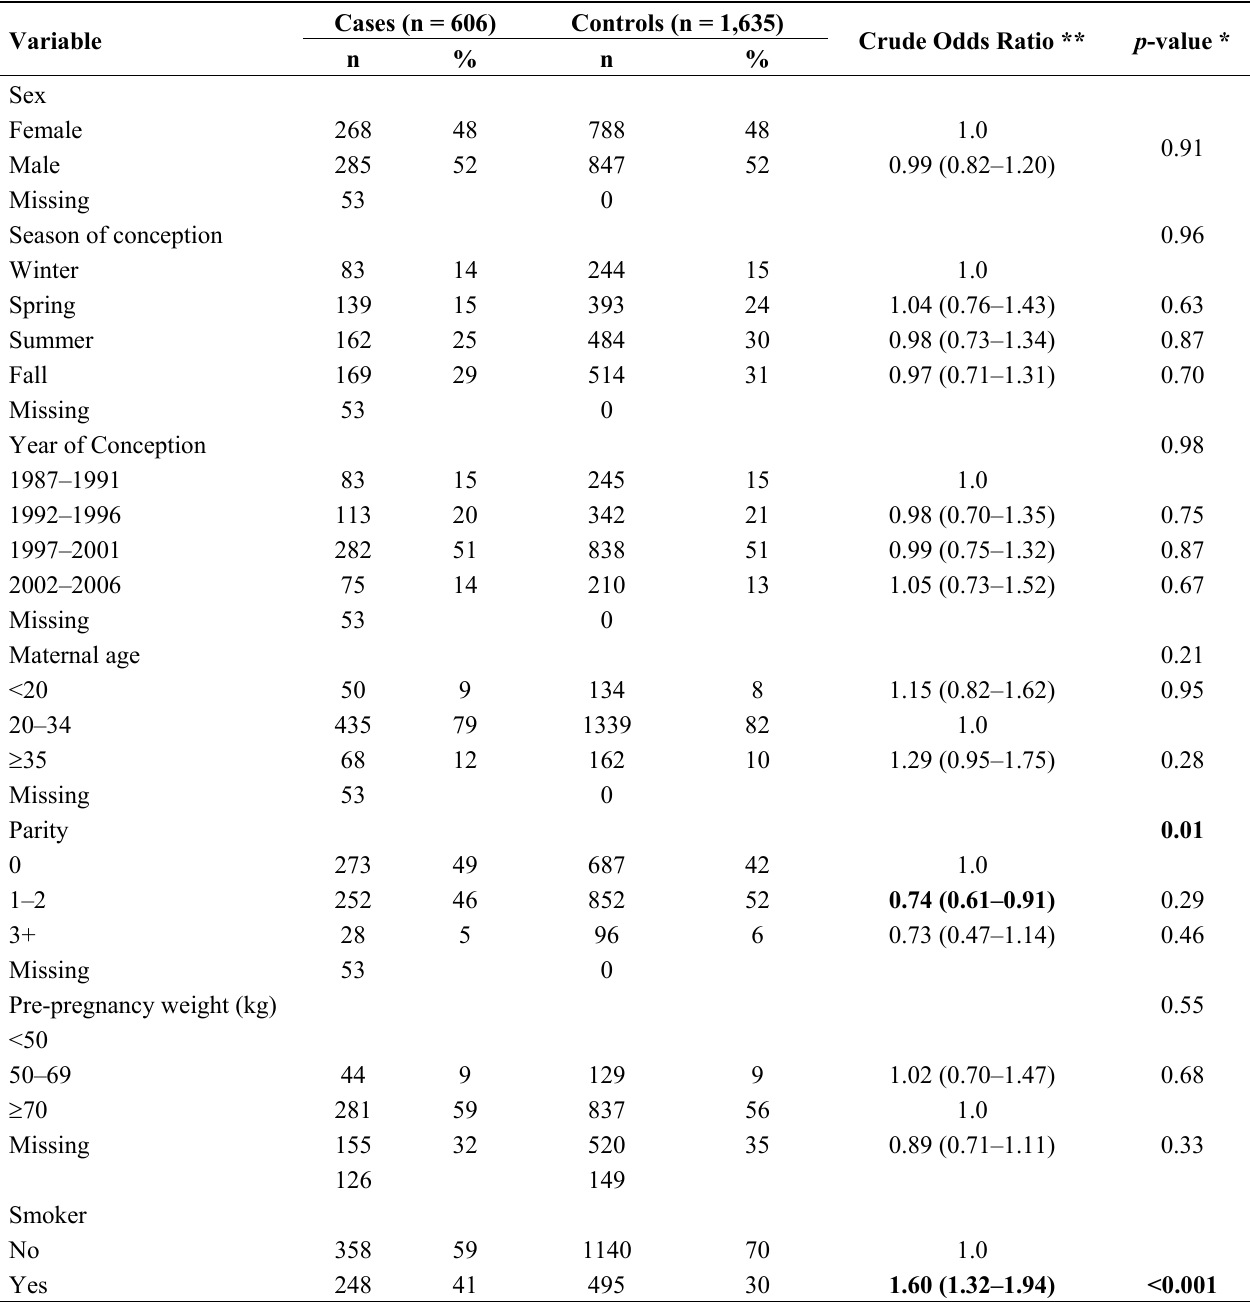
Table 3. Distribution of matching, demographic, health and water source variables, including nitrate exposure level, between cases of congenital anomalies and controls, as well as univariable logistic regression odds ratios between incidence of congenital anomalies and all variables for cases and controls